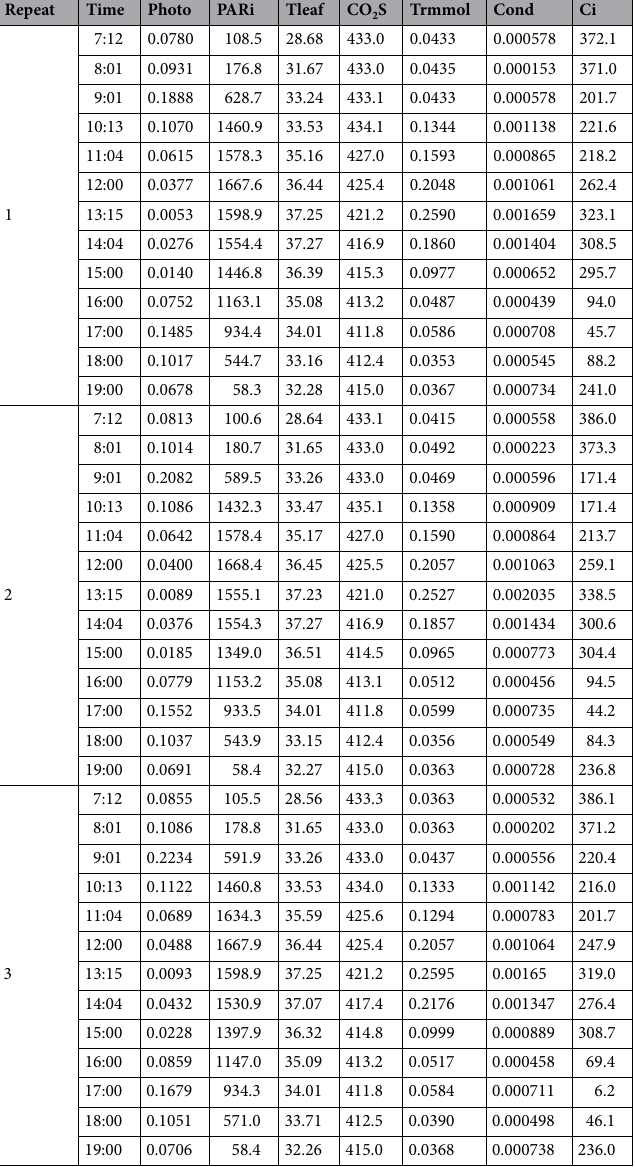
Table 1. Diurnal variations in Epimedium brevicornu leaves photosynthesis. Photo, photosynthetic rate, unit: µmol CO thermocouple, unit: °C. CO 2 S, sample cell CO 2 , unit: µmol mol −1 . Trmmol, transpiration rate, unit: mmol H 2 O m −2 s −1 . Cond, conductance to H 2 O, unit: mol H 2 O m −2 s −1 . Ci, intercellular CO 2 concentration, unit: μmol CO